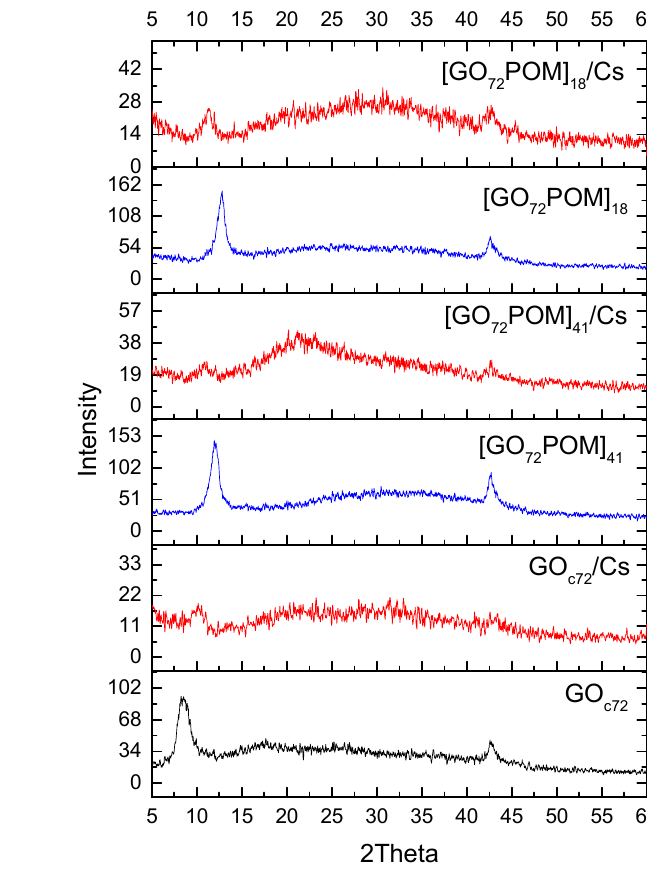
Figure 4. PXRD patterns of GO c70 , GO c72 , and their GO-POM nanocomposite before and after Cs adsorption. As discussed above, these data have a good correlation with the information that is observed in Raman spectra. Based on Raman analysis (Figures 5 and S9–S12 (see supporting information)), it was found that the change in spectrum by Cs adsorption was similar for both the GO-only samples and composite samples. It can be seen that the second-order peaks have changed after Cs adsorption. In previous studies, it was strengthened that the second-order peak indicates that the crystallite size has changed. This indicator showed that the spectrum broadens consistently with decreasing the domain size [59]. Therefore, during the chemical processing (Cs adsorption), the significant structural change of the carbon framework occurred. In addition, based on the sample experiment using [GO 39 POM] 41 , there is a slight shift in the D band from 1347 cm − 1 before Cs adsorption to 1352 cm − 1 after Cs adsorption. The same shift also occurred in the other samples, [GO 70 POM] 18 and [GO 70 POM] 41 (Figure S9, see supporting information). It might be caused by the interaction of oxygen functional groups and the hole defect in the GO sheets with Cs cation [58]. Thus, the change that the crystal structure after Cs adsorption has altered by amorphization could be